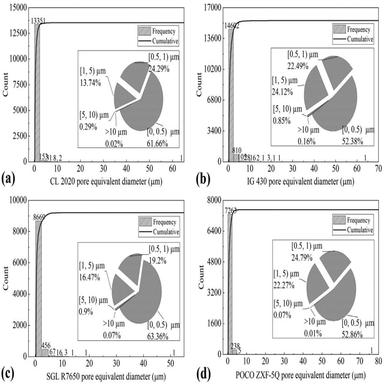
Statistics of pore equivalent diameter for the four grades of graphite at micrometre scale from XCT data: (a) CL 2020 graphite, total pore number: 13546 and, (b) IG 430 graphite, total pore number: 15570 and, (c) SGL R7650 graphite, total pore number: 9214 and, (d) POCO ZXF-5Q graphite, total pore number: 7507.